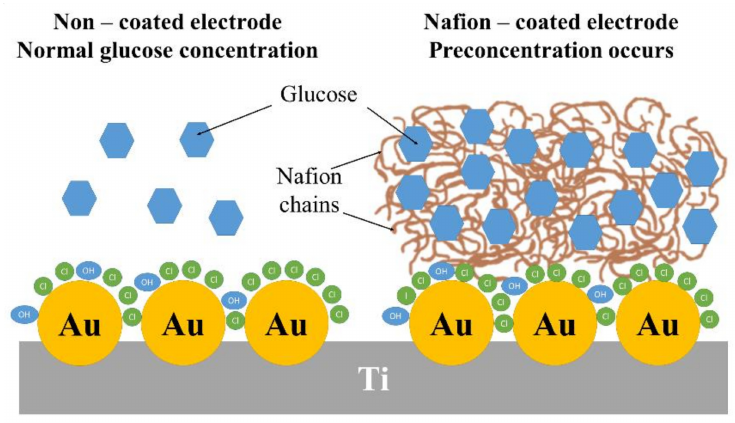
Figure 11. Schematic illustration of the e ff ect of Nafion coating on the concentration of glucose in the vicinity of the electrode.